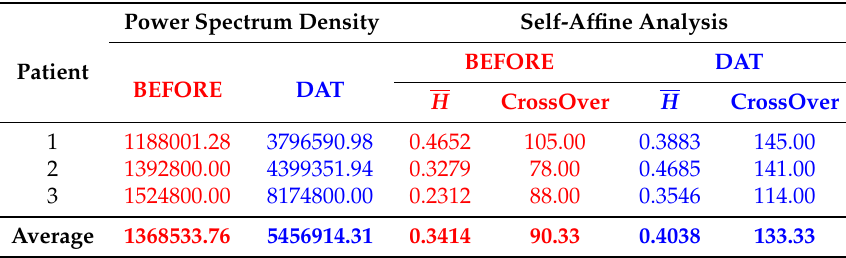
Figure 7. Results of Dolphin-Assisted Therapy (DAT) efficiency for RAW EEG Brain activity (first row, ( a )–( c )) of three child patients with Infantile Spastic Cerebral Palsy (ISCP) (each column is a patient). Periodogram (second row, ( d )–( f )) and Average Spectogram (third row, ( g )–( i )) using FFT Power Spectrum Density. Fluctuations EEG Brain activity (fourth row, ( j )–( l )) and Crossover (fifth row, ( m )–( o )) using Self-Affine Analysis . The functions in red mean that the sample was taken before DAT, while the blue ones mean during DAT. Table 5. Summary of the experimental results of Experiment